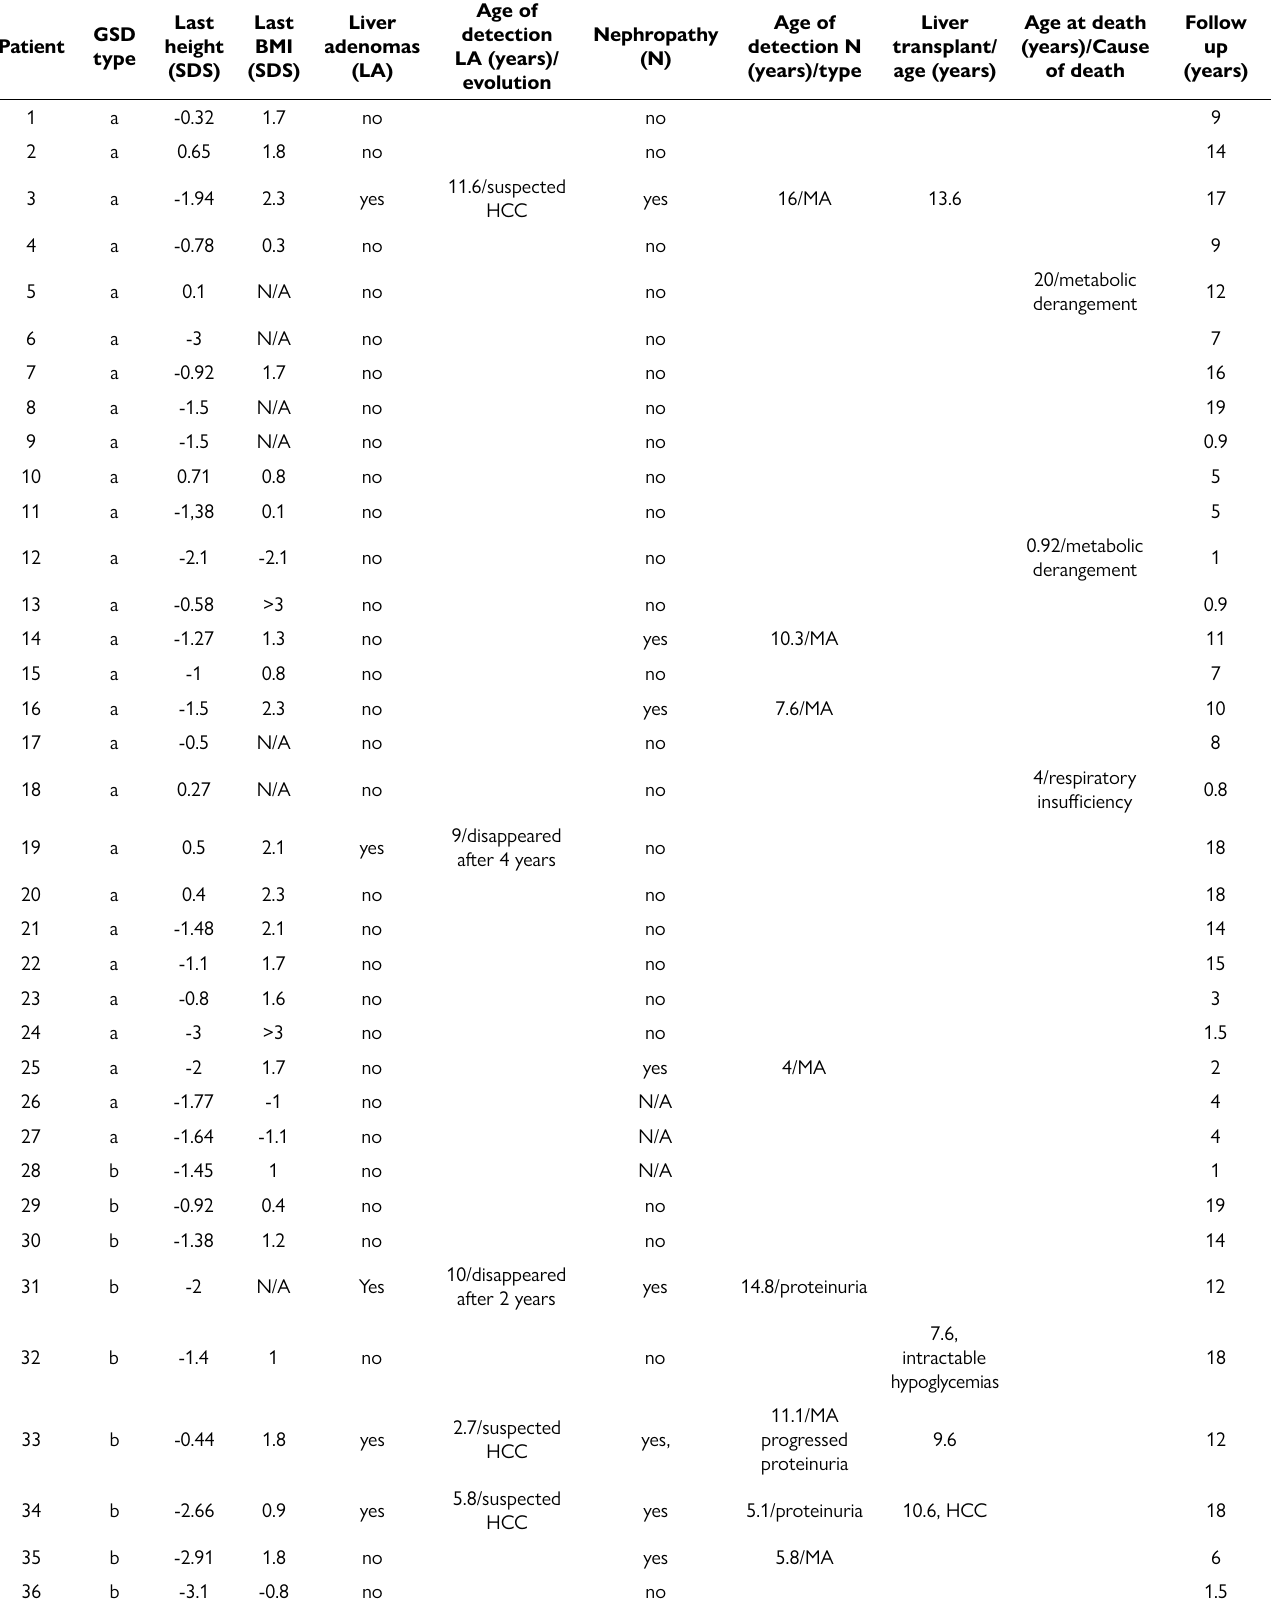
Table 2. Clinical features during follow-up and last anthropometric assessment of GSD I